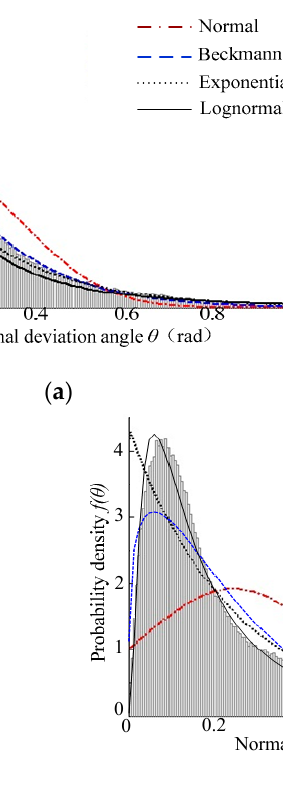
Figure 10. Distribution results for the normal declination angle of the Ra 3.2 machined surface topography: ( a ) Turning surface, ( b ) plain milling, and ( c ) boring surface.